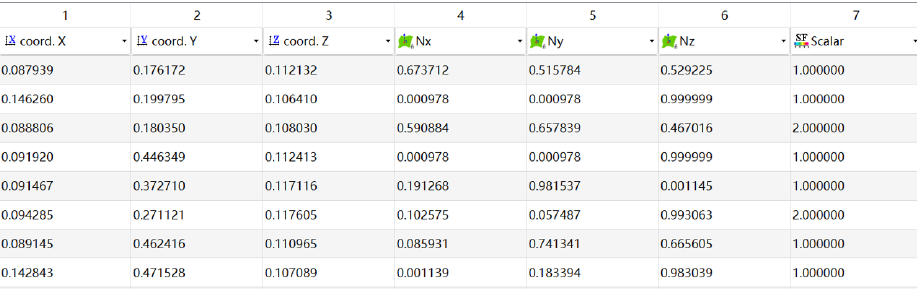
Figure 9. Visualizationof the labeled data formation. Table 3. Summary of the proposed 3D spacecraft component segmentation dataset.